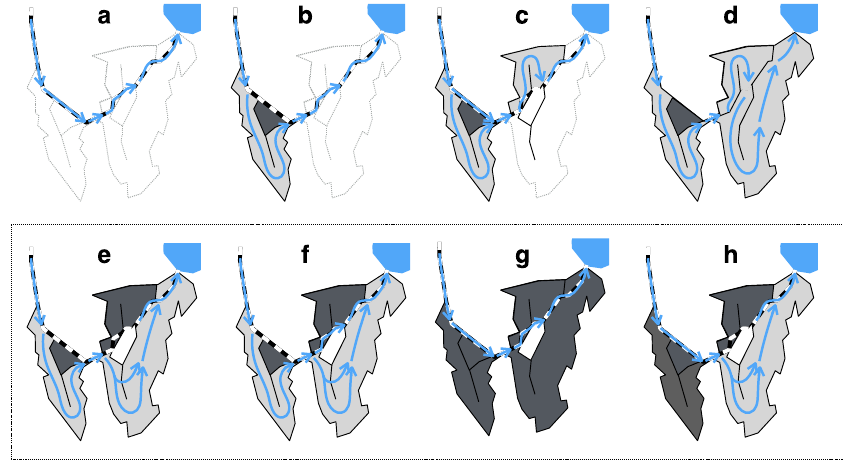
Figure 3. Historical ( a – c ), originally planned ( d ), and present ( e – h ) operational setups of the Kis-Balaton. ( a ): before 1985; ( b ): 1985–1992; ( c ): 1993–2013; ( d ): original plan of the complete system, ( e – h ): main flow routing options since 2014; ( e ) shows the normal way of operation. Dark shading indicates stagnant / bypassed water bodies, blue arrows show flow paths. Flow sequences using the codes from Figure 2 are as follows: in ( a ) ZA ζ BL, in ( b ) ZH ζ BL, in ( c ) ZH ζ IL, in ( d ) ZH ζ IFL, in ( e ) ZH ζ FL, in ( f ) ZH ζ {2 / B}L, in ( g ) ZA ζ BL, in ( h ) ZA ζ FL. The original plan of the Kis-Balaton was ZH ζ IFL. At present the following flow patterns are also possible: ZH ζ {I / F}L, ZA ζ IL, ZA ζ {I / 2}L, ZAC, where curly brackets indicate parallel alternative pathways.